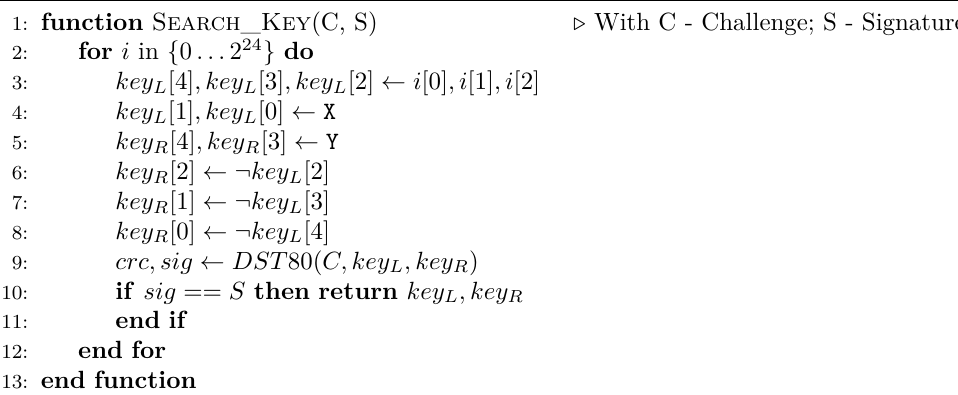
Table 3: Kia and Hyundai immobilisers and their respective DST80 keys. The two 2-byte constants X and Y have been redacted on the manufacturers request. Make Year & Model keyL keyR 2014 Carens 955A3E || X Y || C1A56A Kia 2016 Ceed 724560 || X 2013 I40 756F1E || X Hyundai 2016 IX20 Y || EC84CA Algorithm 3 Recovering DST80 keys for transponders configured for Hyundai and Kia vehicles. The two 2-byte constants X and Y have been redacted on the manufacturers